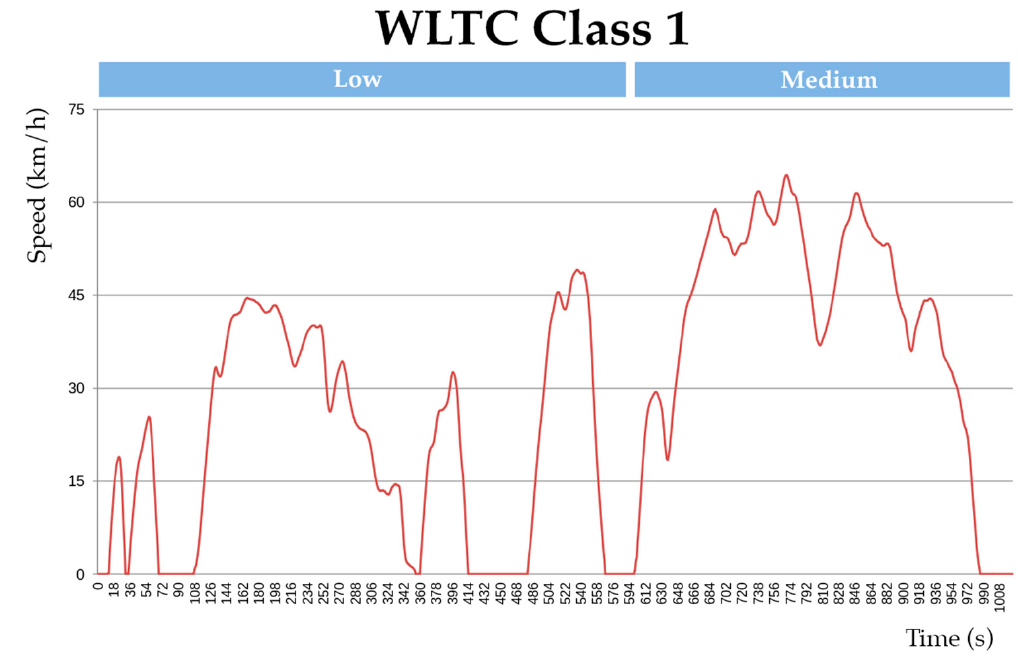
Figure 12. Class 1 WLTC drive cycle.